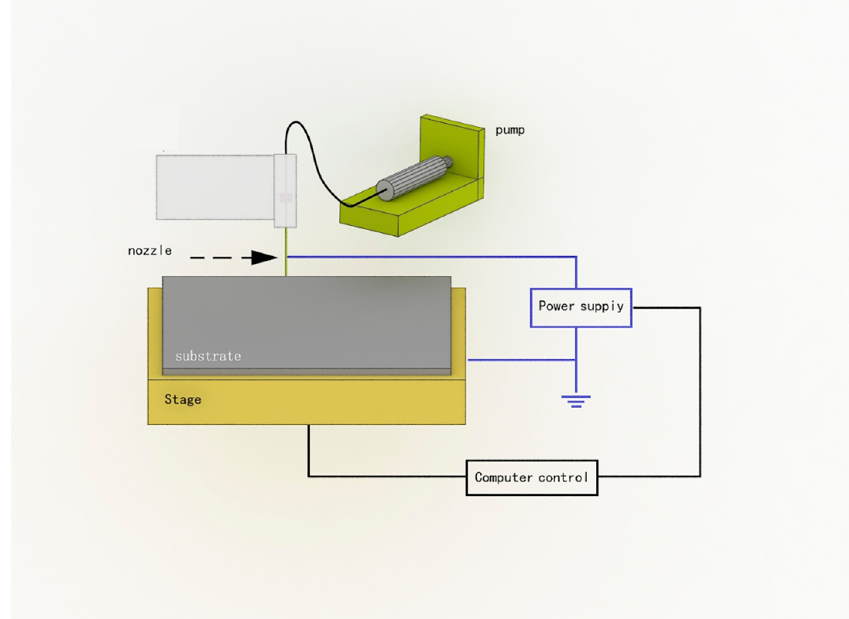
Figure 13. Ink-jet printing schematic diagram of the electric fluid power.